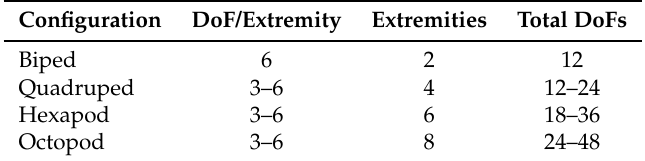
Table 1. Degrees of freedom (DoFs) for different configurations of legged